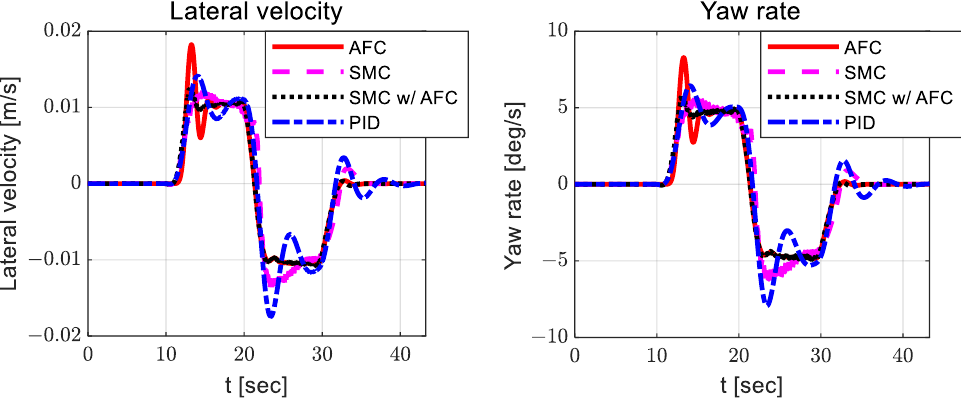
Figure 10. Results: dynamic behaviors (lateral velocity — left ; yaw rate — right ) for the curved path tracking.